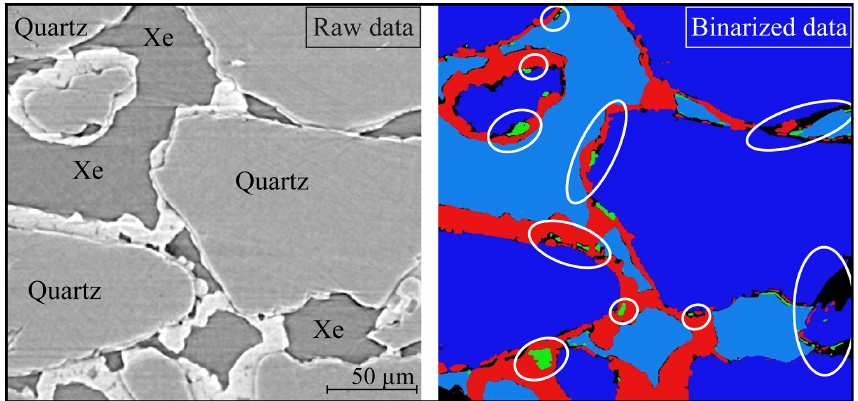
Figure 7. Segmentation problems occurring in samples of low-grade image enhancement